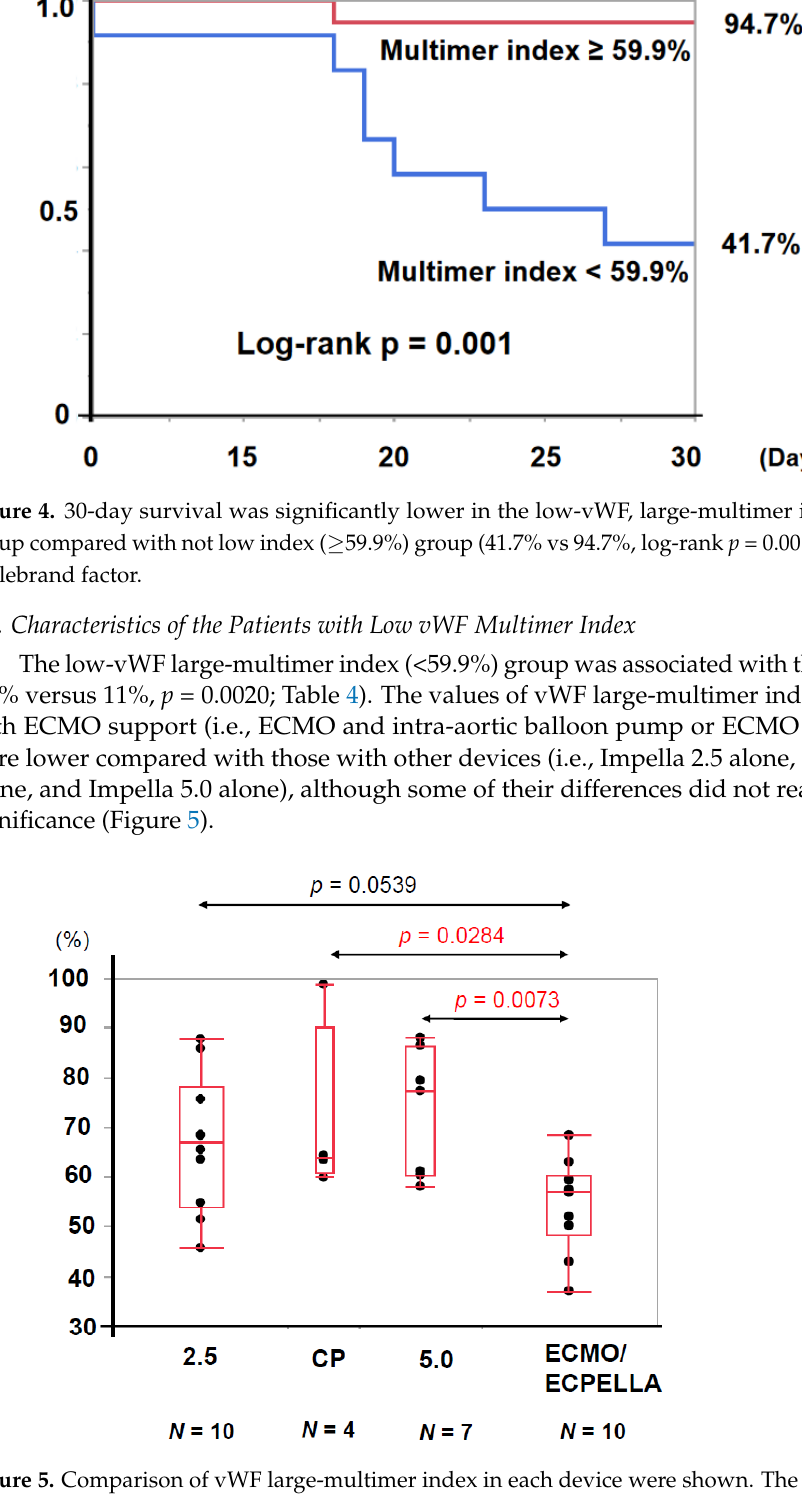
Table 4. Association between low vWF large-multimer index group and other clinical parameters.